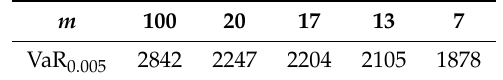
Figure 12. Simulation of 5000 adaptive Bernstein copula points in Example 5, m Area 13. ( b ) Area 3 vs. Area 4. ( c ) Area 7 vs. Area 16. ( d ) Area 3 vs. Area